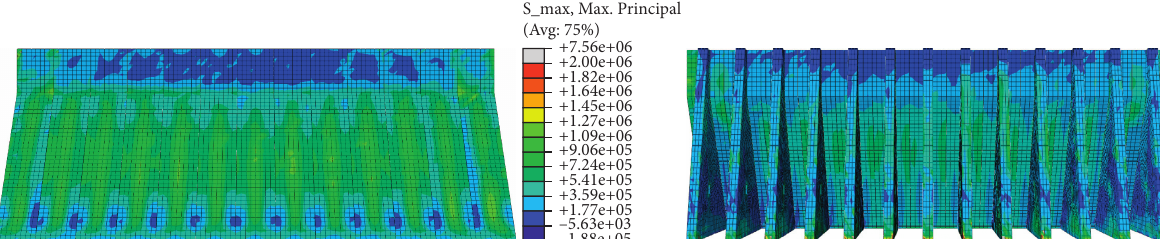
Figure 24: Maximum envelope of maximum principal stresses at upstream and downstream of the buttress dam considering all components of the Taft